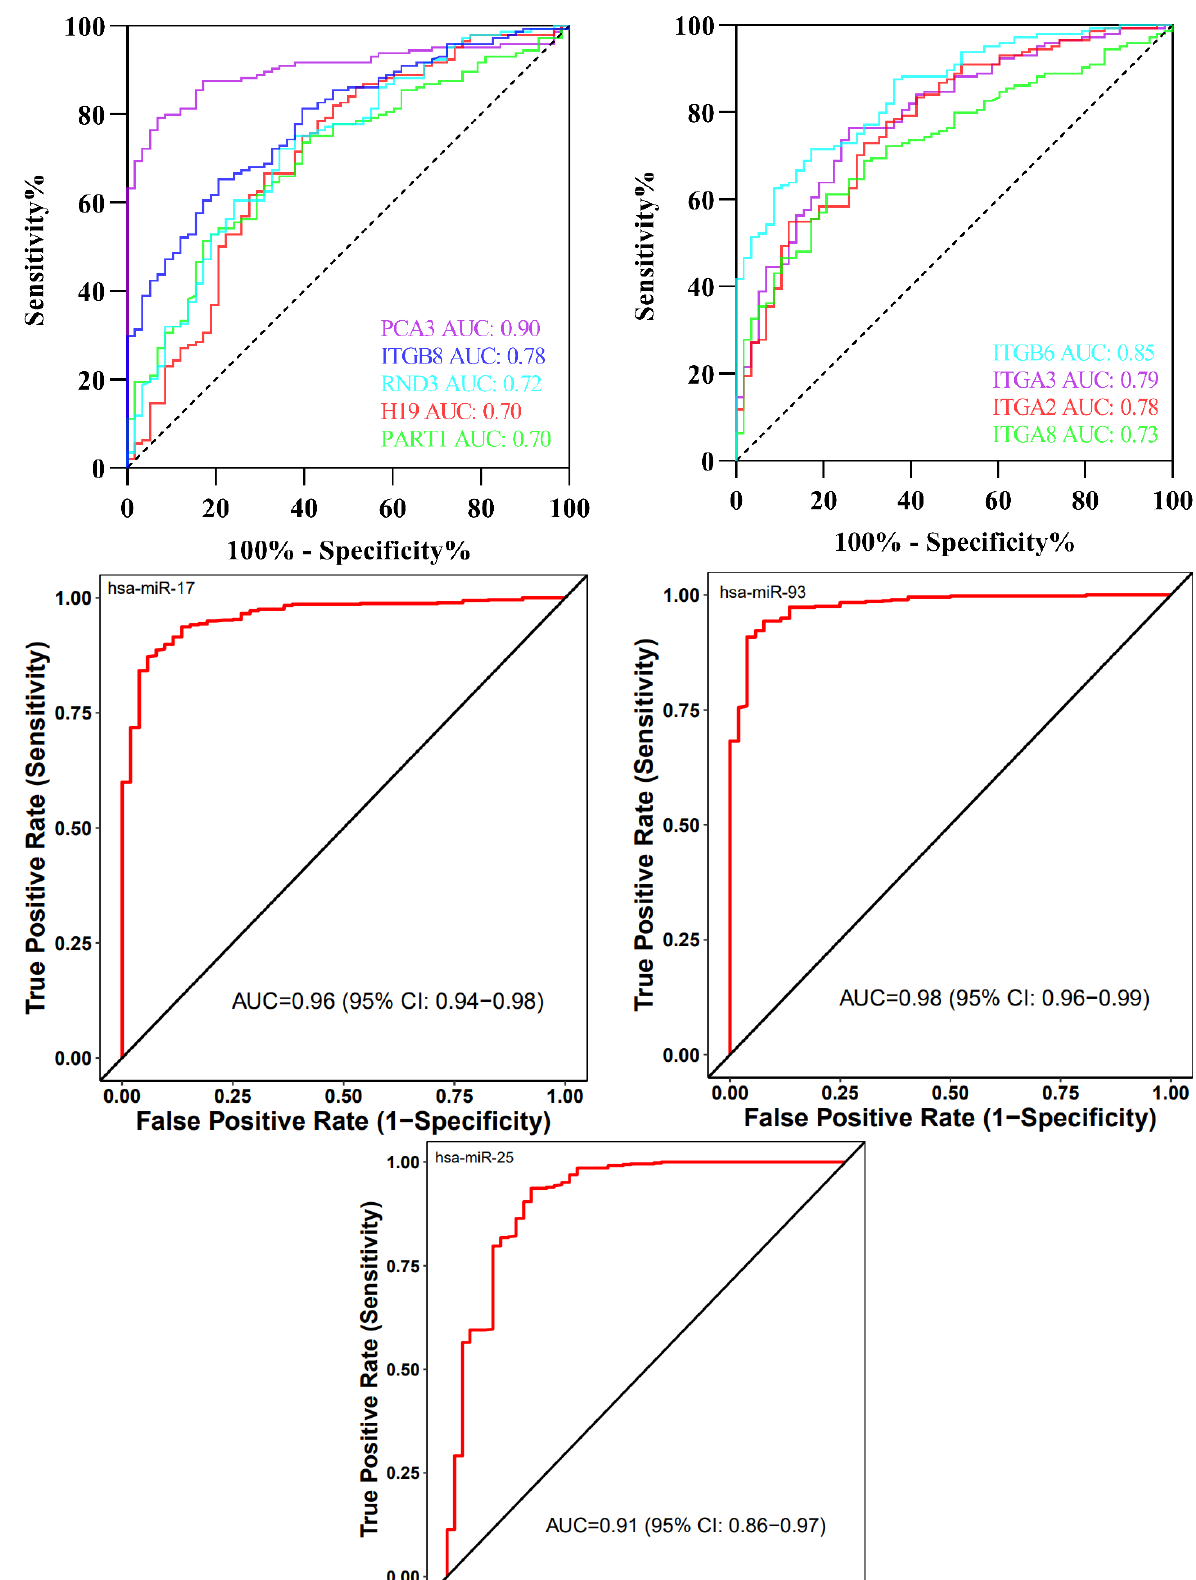
Figure 22. Appraisal of the hub genes. ROC curves for 22 hub genes. The calculated AUC area under the curve for dataset ranged from 0.7 to 1.